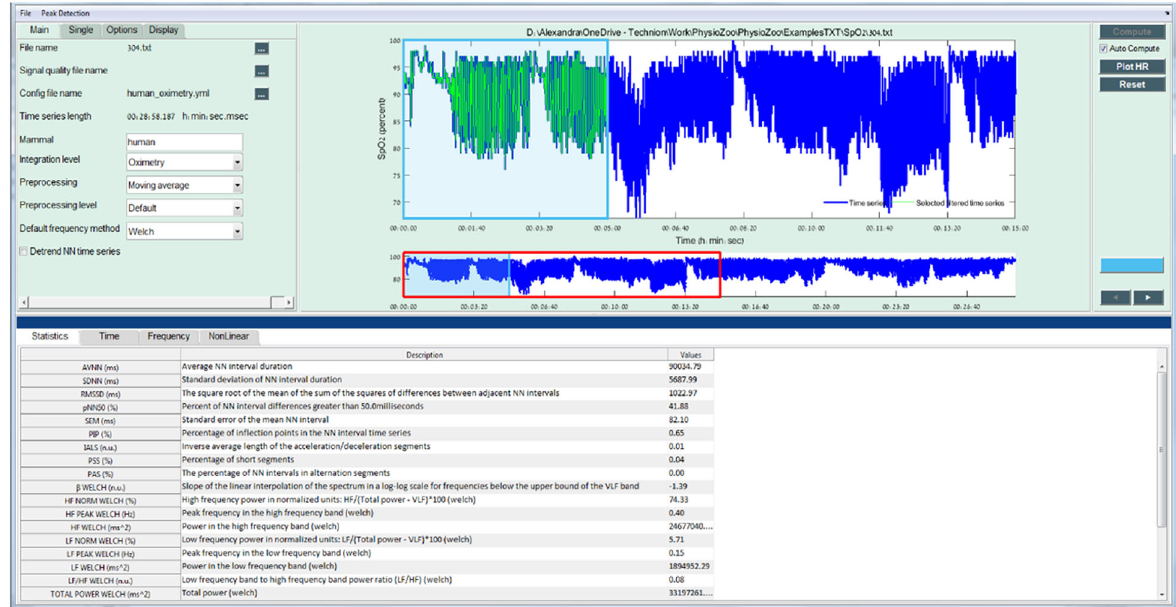
Fig. 1 PhysioZoo OBM interface for oximetry time series analysis. The analysis of an oximetry time series is shown. All the OBM biomarkers are computed for the selected window (in light